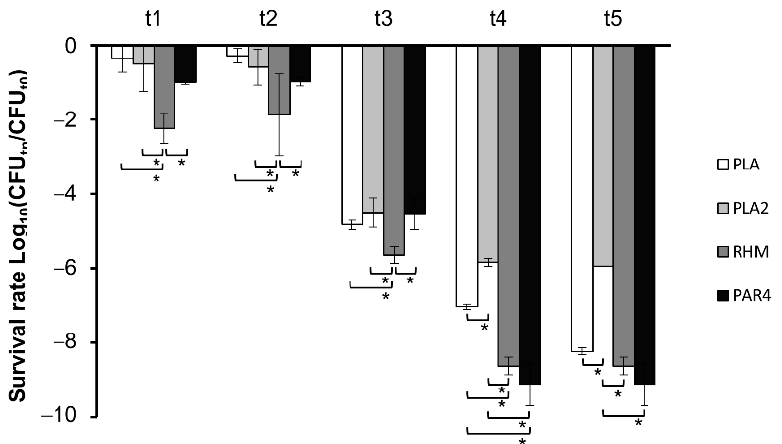
Figure 1. Relative survival of the lactobacilli strains at different steps of the in vitro simulated OGI transit assay. Data shown are means ± standard deviations of three different replicates. t1: oral stress (pH 6.0, Lysozyme); t2: gastric stress (pH 3.0, pepsin); t3 gastric stress (pH 2.0, pepsin); t4: Intestinal stress (pH 6.5, bile salts and pancreatin); t5: intestinal stress (pH 6.5). Data shown are means ± standard deviations. ANOVA test at each time point ( p < 0.05), followed by Fisher’s Least Significant Difference (LSD) test. *: p < 0.001.